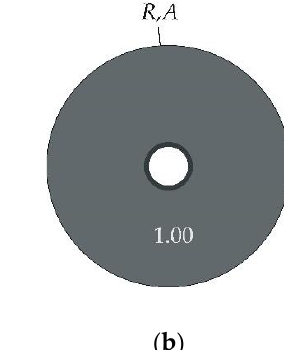
Figure 18. Global sensitivity analysis of P f from Z based on Rényi entropy: ( a ) dependence of Rényi entropy on P f ; ( b ) first- and second-order sensitivity indices of R and A .